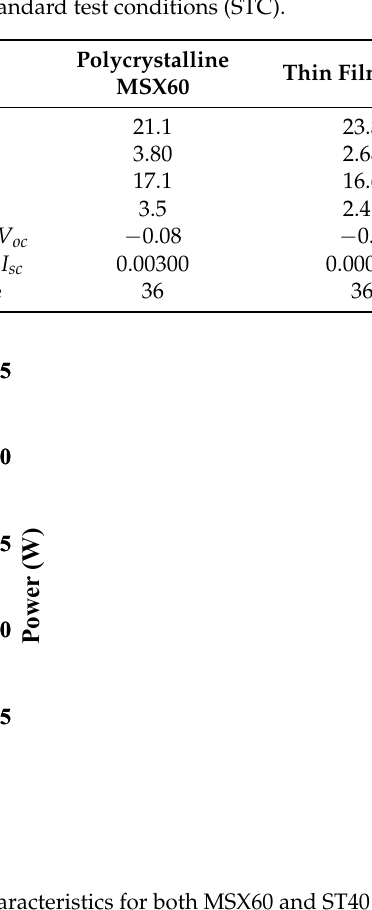
Figure 2. I-V (Solid lines) and P-V (Dashed lines) characteristics for both MSX60 and ST40 modules. The incident solar irradiance and temperature influence these characteristic